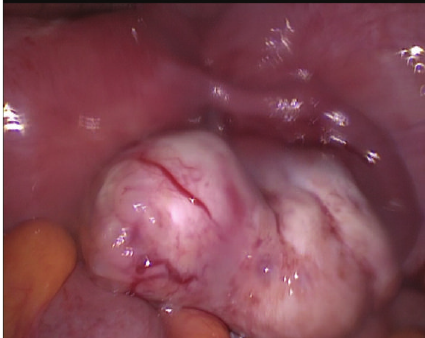
Figure 3: High power view of the ovarian leiomyoma composed of interlacing spindle cells with characteristic cigar-shaped nuclei (H&E).